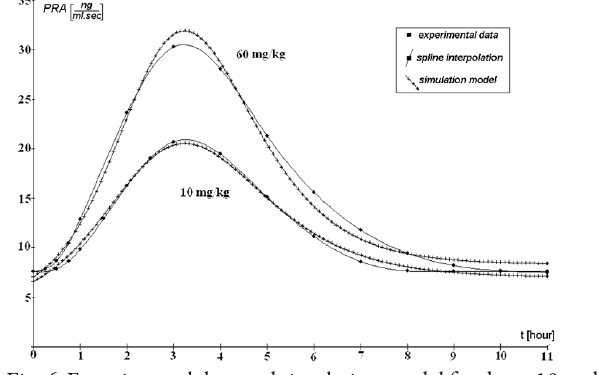
Fig. 3. Carrying capacities K